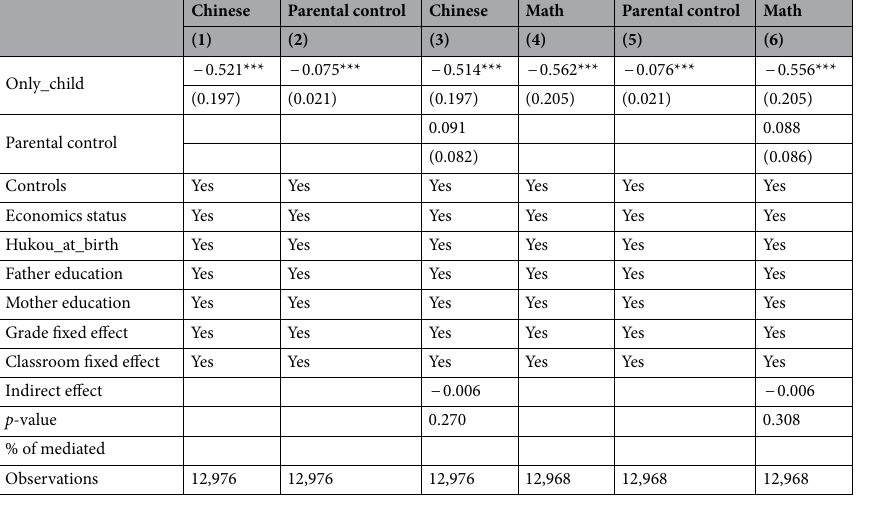
Table 12. Mechanism: Parental control. Notes: Standard errors in parentheses, adjusted for within-classroom clustering. * p < 0.10. ** p < 0.05. *** p < 0.01.